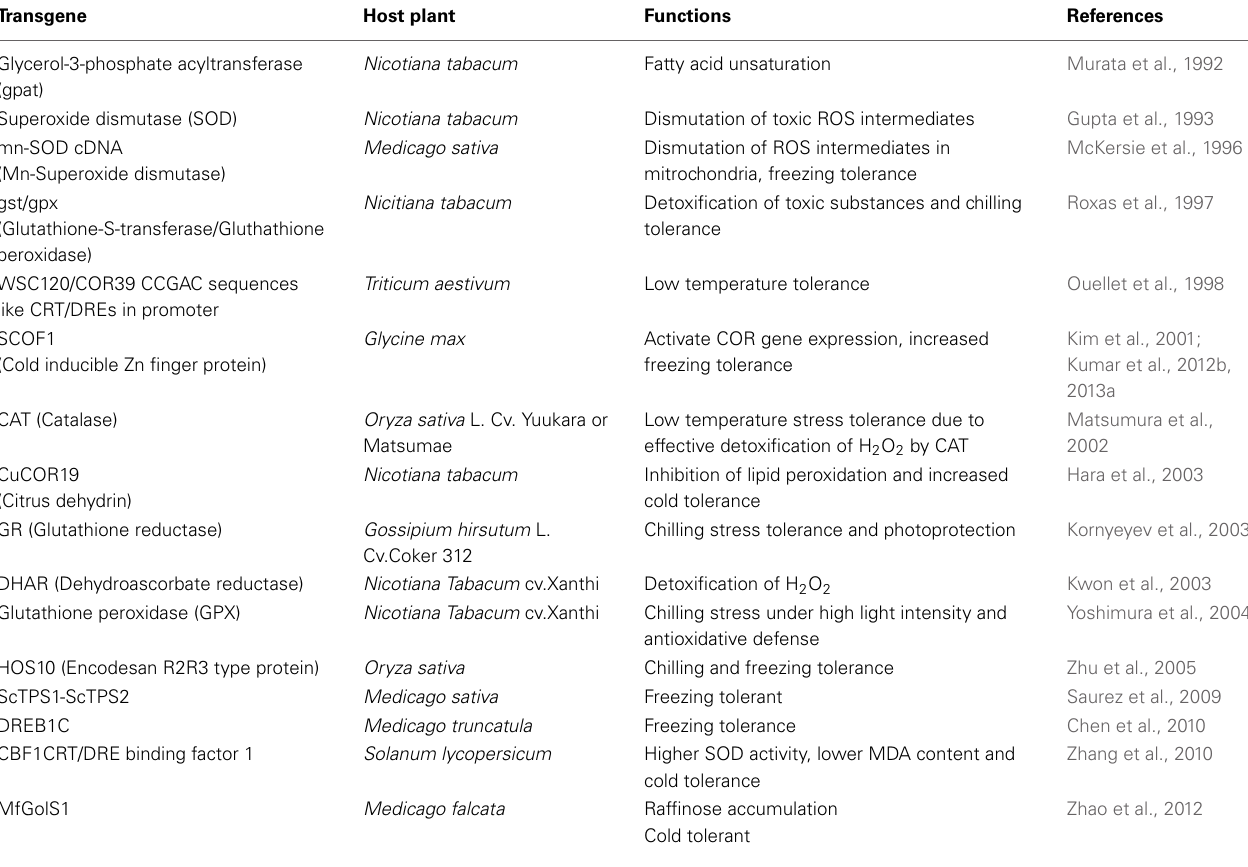
Table 3 | Transgenics for cold tolerance and involvement of ROS scavenging